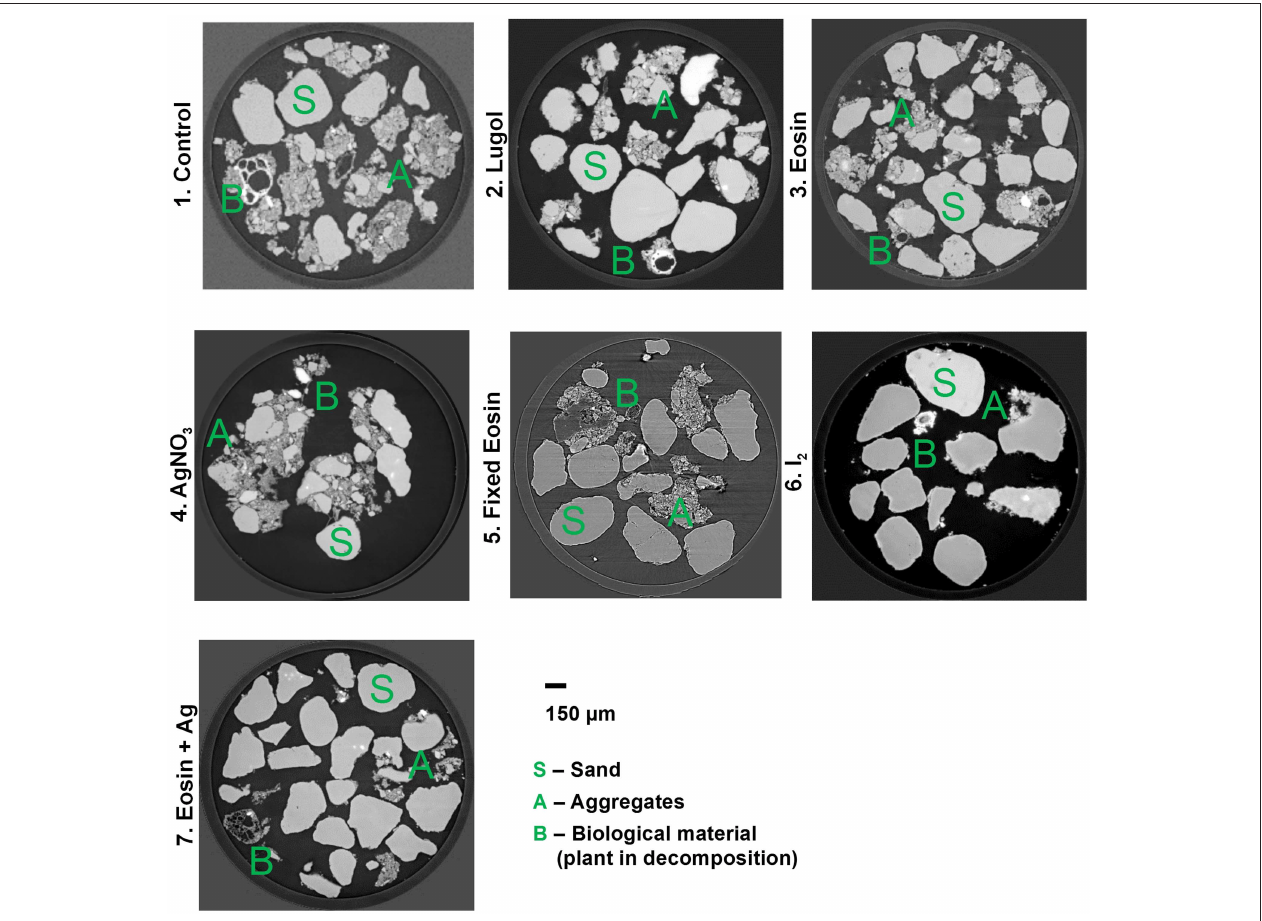
FIGURE 1 | Reconstruction images (X-Y plane) of the synchrotron based X-ray tomographies (16 keV and voxel size 0.438 µ m) of soil samples: (1) control, (2) stained with Lugol (liquid I), (3) Eosin, (4) AgNO 3 , (5) Sample fixed with formaldehyde and stained with AgNO 3 , (6) I 2 , (7) Eosin + AgNO 3 . Details are highlighted in Figure 2 , where biological material can be better